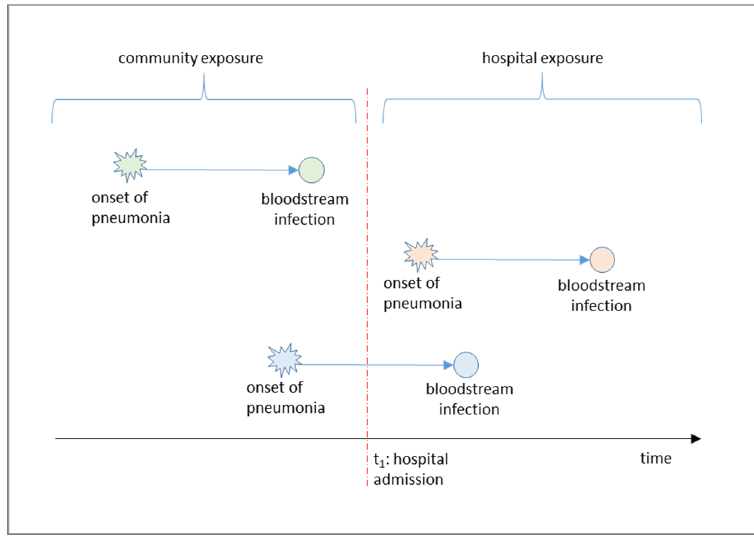
Figure 1. The contextual framework of the study.